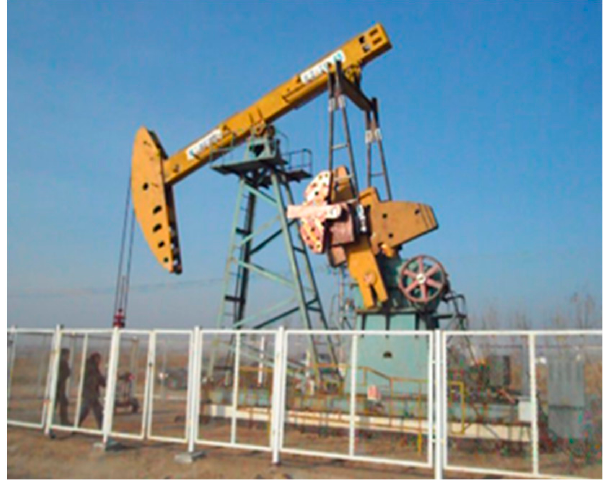
Figure 14. Field test photo of beam positive torque unit. The motor torque curve and the motor active power curve before and after the trans- formation of CYJ10-4.2-53HF pumping unit in B2-D2-56 well are shown in Figure 15a,b, respectively, and the working condition comparison table is shown in Table 1. The well conditions before and after the transformation are essentially the same. Following transfor- mation, the maximum value of torque is obviously reduced, the minimum value becomes larger, the fluctuation is gentler, the torque is all positive, and the purpose of positive torque transformation is achieved. After the transformation, daily power consumption was reduced from 259.71 kWh to 195.5 kWh and power consumption per ton of liquid was reduced from 2.36 kWh to 1.80 kWh, with a power saving rate of 23.73%; the system efficiency was increased from 20.6% to 35.1%, with an improvement of 14.5%. After two years of on-site use, no abnormalities were found.